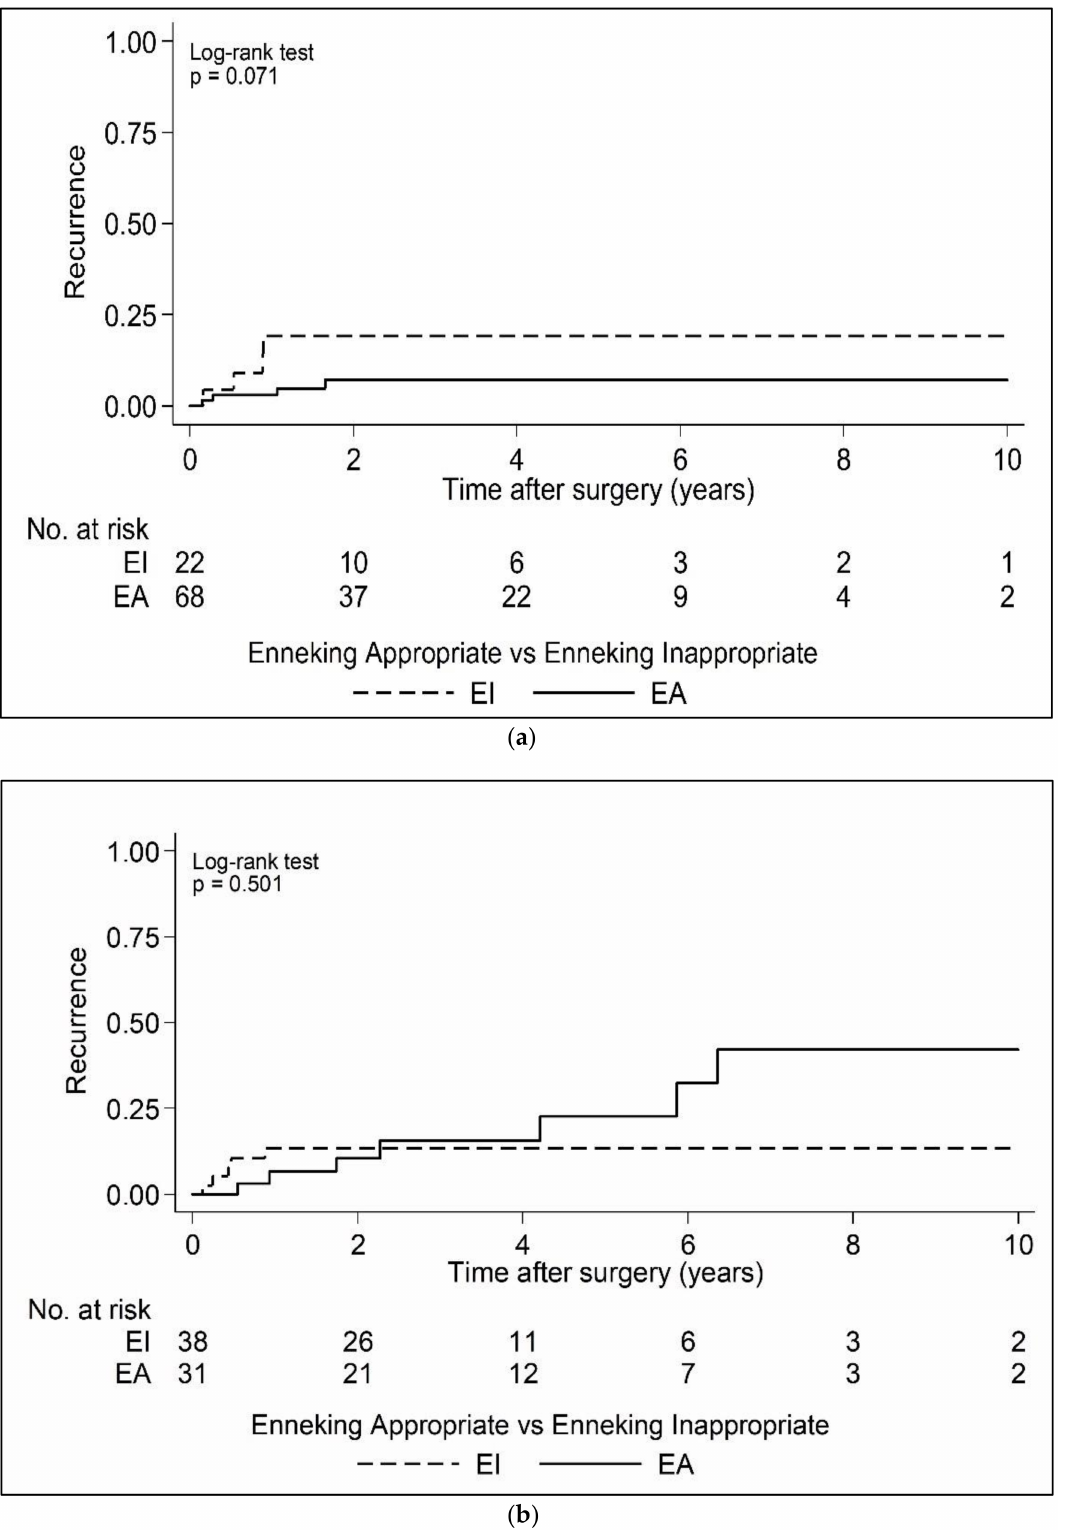
Figure 3. Kaplan–Meier curves of time to first local recurrence following surgery by Enneking appropriateness for less aggressive entities ( a ) and GCT/OBL patients ( b